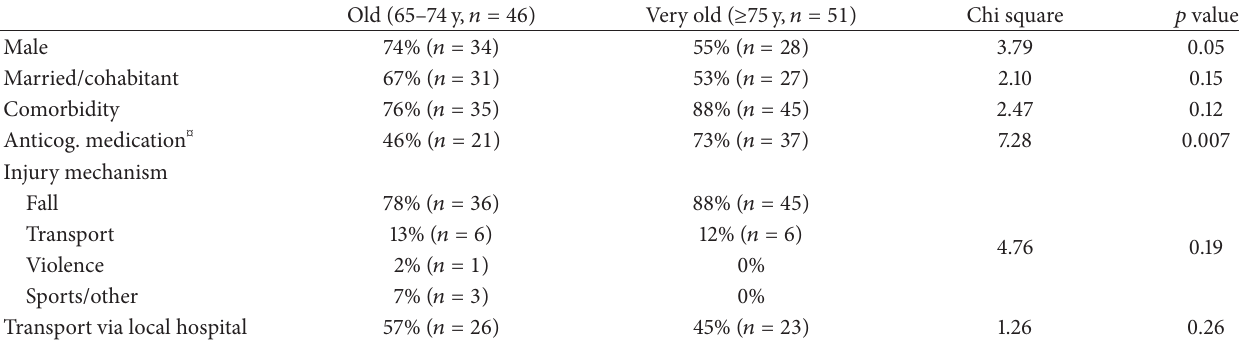
Table 1: Demographic characteristics and injury mechanisms of the old (65–74 years) and very old (75–92 years) are presented.